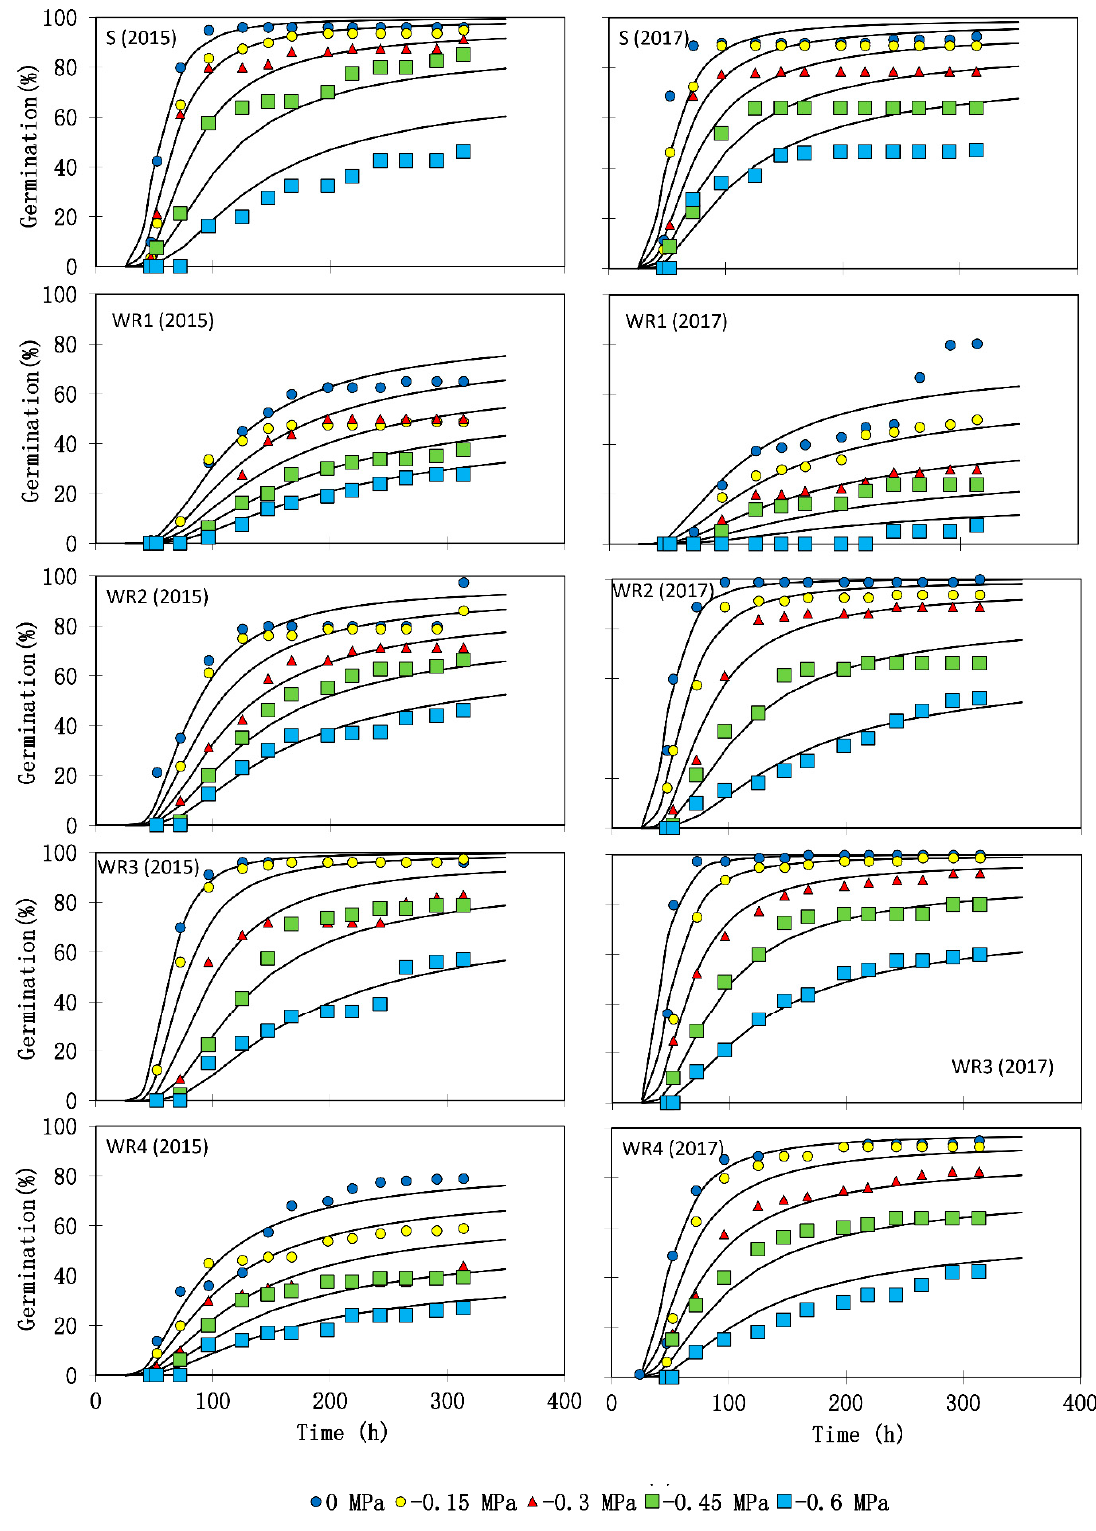
Figure 3. Germination time courses of five Avena sterilis ssp. ludoviciana biotypes (susceptible biotype (S) or resistant biotypes (WR 1 –WR 4 )). Symbols indicate interpolations of observed germination data and lines germination time courses predicted by the hydrotime model based on parameter estimates in Table 6. The symbols represent the mean of three